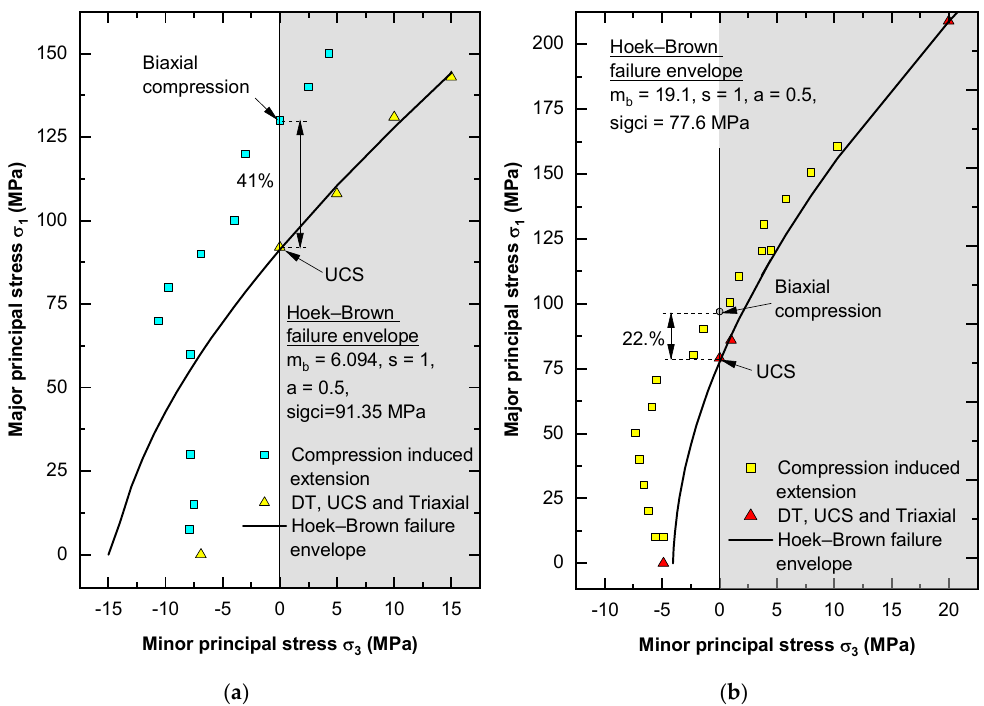
Figure 4. Results of confined extension test for ( a ) Carrara marble [23] and ( b ) Berea sandstone [21]. Direct tension (DT), UCS, triaxial compression, and confined extension test results as well as the Hoek–Brown failure envelopes are shown. The biaxial strength of the Berea sandstone was calculated using